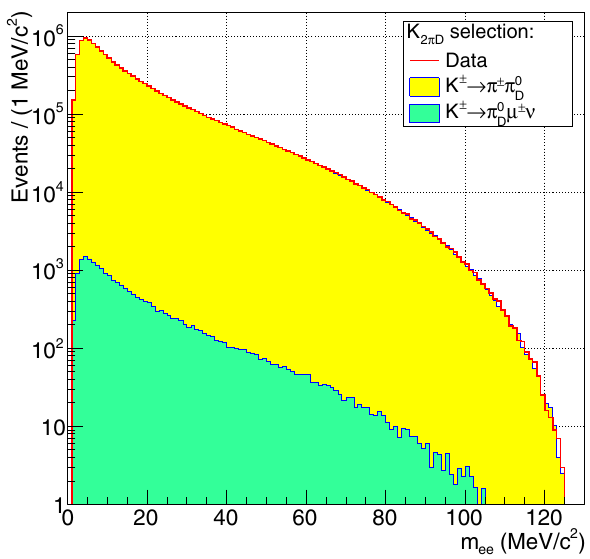
Fig. 38 Invariant mass ( m ee ) distribution of data and MC events pass- ingthe K 2 π selection.A dark photon signal would correspond toa spike in the m ee